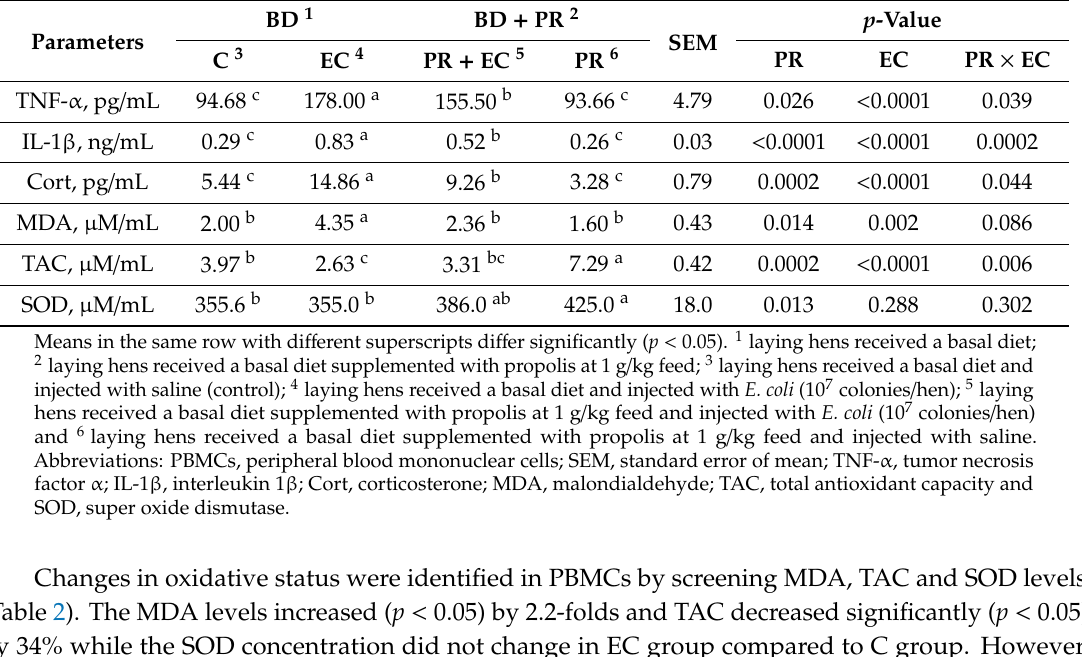
Table 2. The e ff ects of dietary propolis supplementation and E. coli challenge on levels of inflammatory biomarkers and antioxidant status in peripheral blood mononuclear cells (PBMCs), and plasma corticosterone concentration in laying hens ( n =